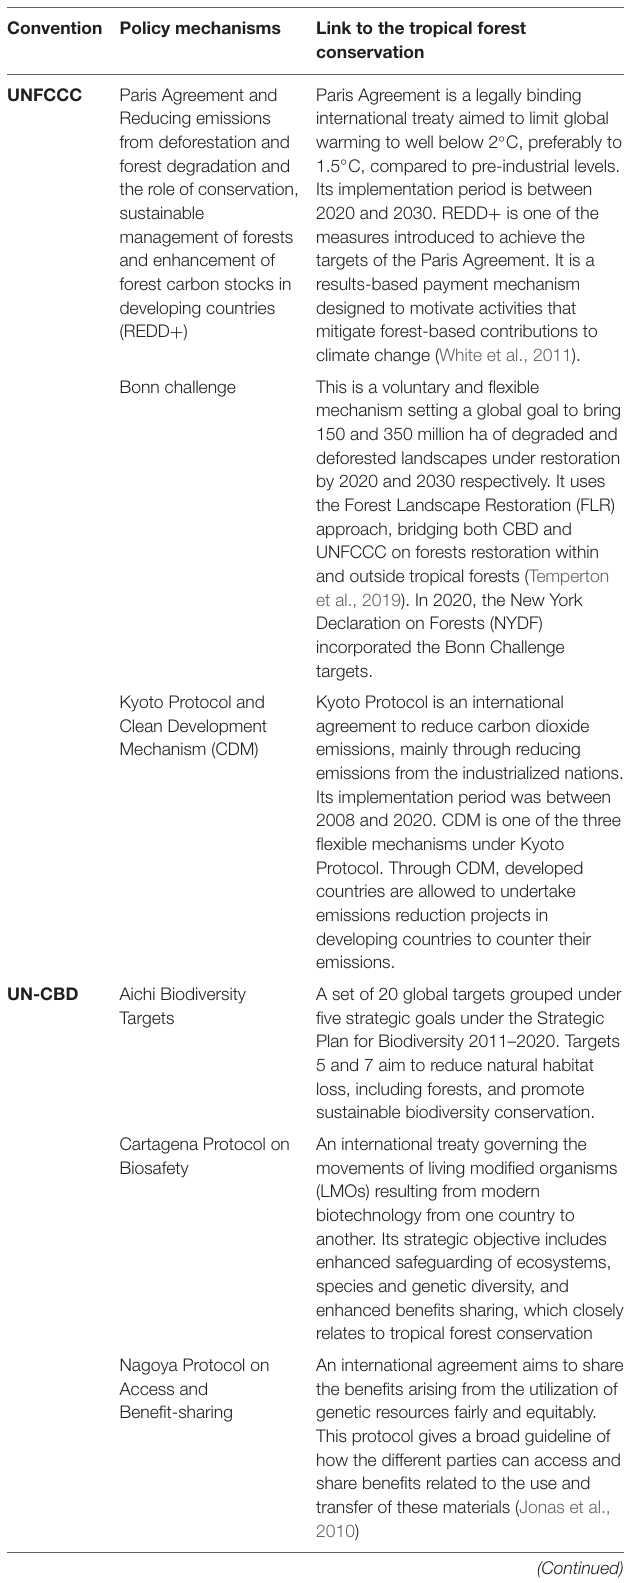
TABLE 1 | Different policy mechanisms under the UNFCCC, UNCCD, and